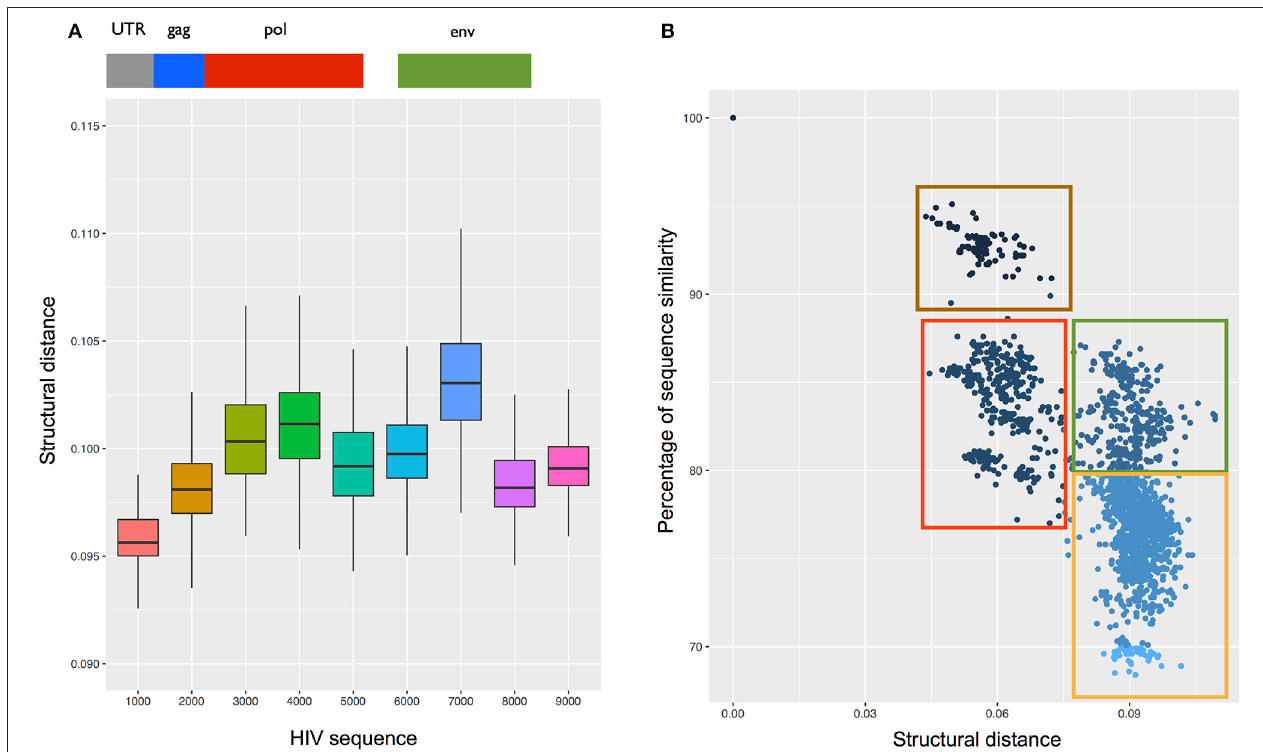
FIGURE 8 | Structural analysis of the HIV transcriptome. (A) Structural conservation of HIV genome (divided into 10 not overlapping regions) compared with the complete genome of 292 ssRNA viruses. The region spanning the first 1000 nt (including 5 ′ UTR) is the most conserved among all the viruses. (B) CROSSalign distances of the complete HIV genome against the complete genomes of 4884 HIV strains. Using analysis of primary and secondary structures, we identified four main clusters (red, green, brown, and yellow). Red and green boxes indicate strains whose structural difference cannot be identified through sequence analysis, while brown and red boxes as well as green and yellow boxes identify strains with similar structures and different